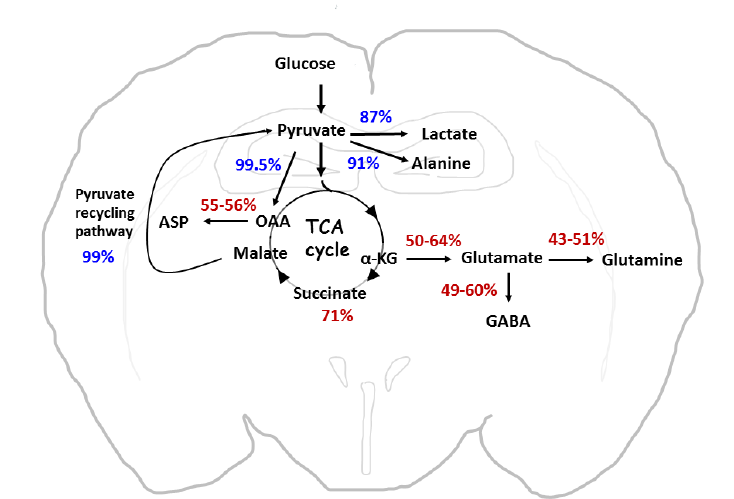
Figure 7. Schematic of metabolism in brain from SIRT3 KO mice compared to WT mice. Numbers represent percent of metabolism in brain from SIRT3 KO mice compared to WT mice. The percent metabolism is calculated from the data in Figures 2–6. A range is indicated where there is a difference in labeling of the different isotopomers of the compound. Numbers in blue indicate pathways that are not different in SIRT3 KO and WT brain. Numbers in red show pathways that are significantly decreased in brain from SIRT3 KO mice compared to WT mice. Abbreviations: ASP, aspartate; α -KG, α -ketoglutarate; OAA, oxaloacetate.